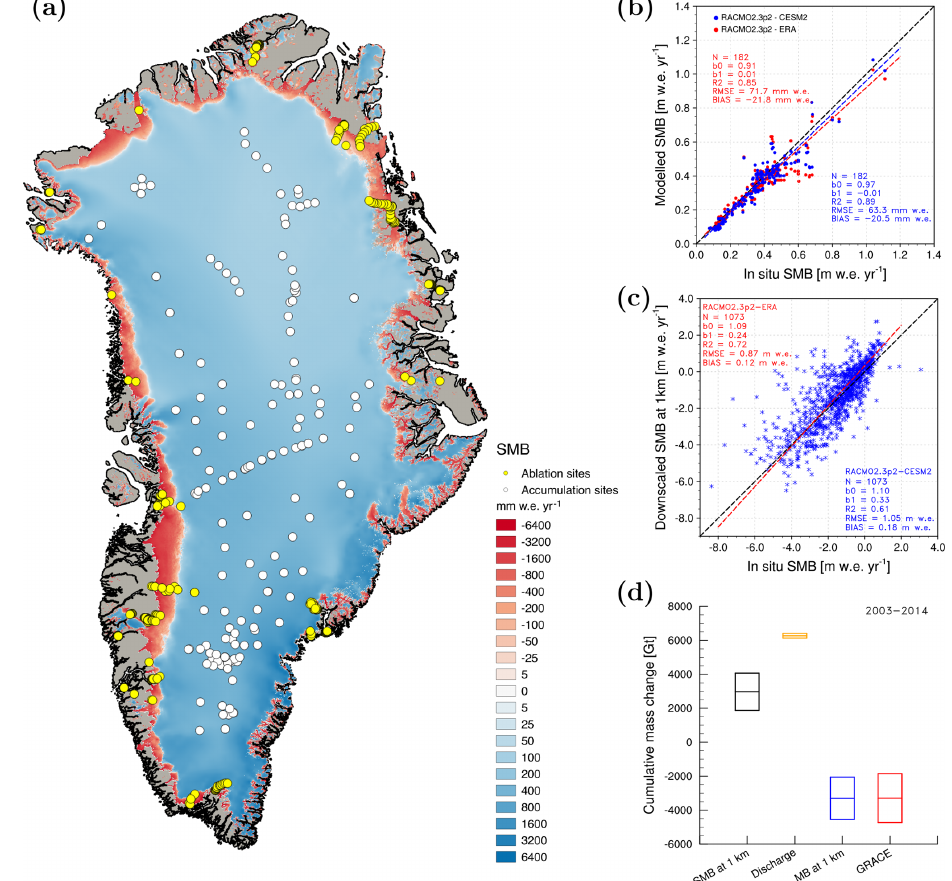
Figure 1. (a) Annual mean SMB (1950–2014) as modelled by RACMO2.3p2 forced by CESM2, statistically downscaled to 1km resolution. (b) SMB evaluation in the accumulation zone (182 sites; white dots in a ) and (c) in the ablation zone of the GrIS (213 sites; yellow dots in a ). Statistics including the number of observations ( N ), slope ( b 0) and intercept ( b 1) of the regressions, determination coefficient ( R 2 ), RMSE and bias are listed for the ERA (red) (Noël et al., 2018) and CESM2-forced RACMO2.3p2 simulation (blue). (d) Period (2003–2014) cumulative SMB (black), glacial discharge (orange) (Mouginot et al., 2019), mass balance (MB = SMB − discharge; blue) and mass loss derived from GRACE (red) (Wouters et al., 2013). To enable a direct comparison with GRACE in (d) , SMB is integrated over the GrIS, peripheral ice caps and tundra regions of Greenland. Boxes represent 1 standard deviation around the mean (horizontal